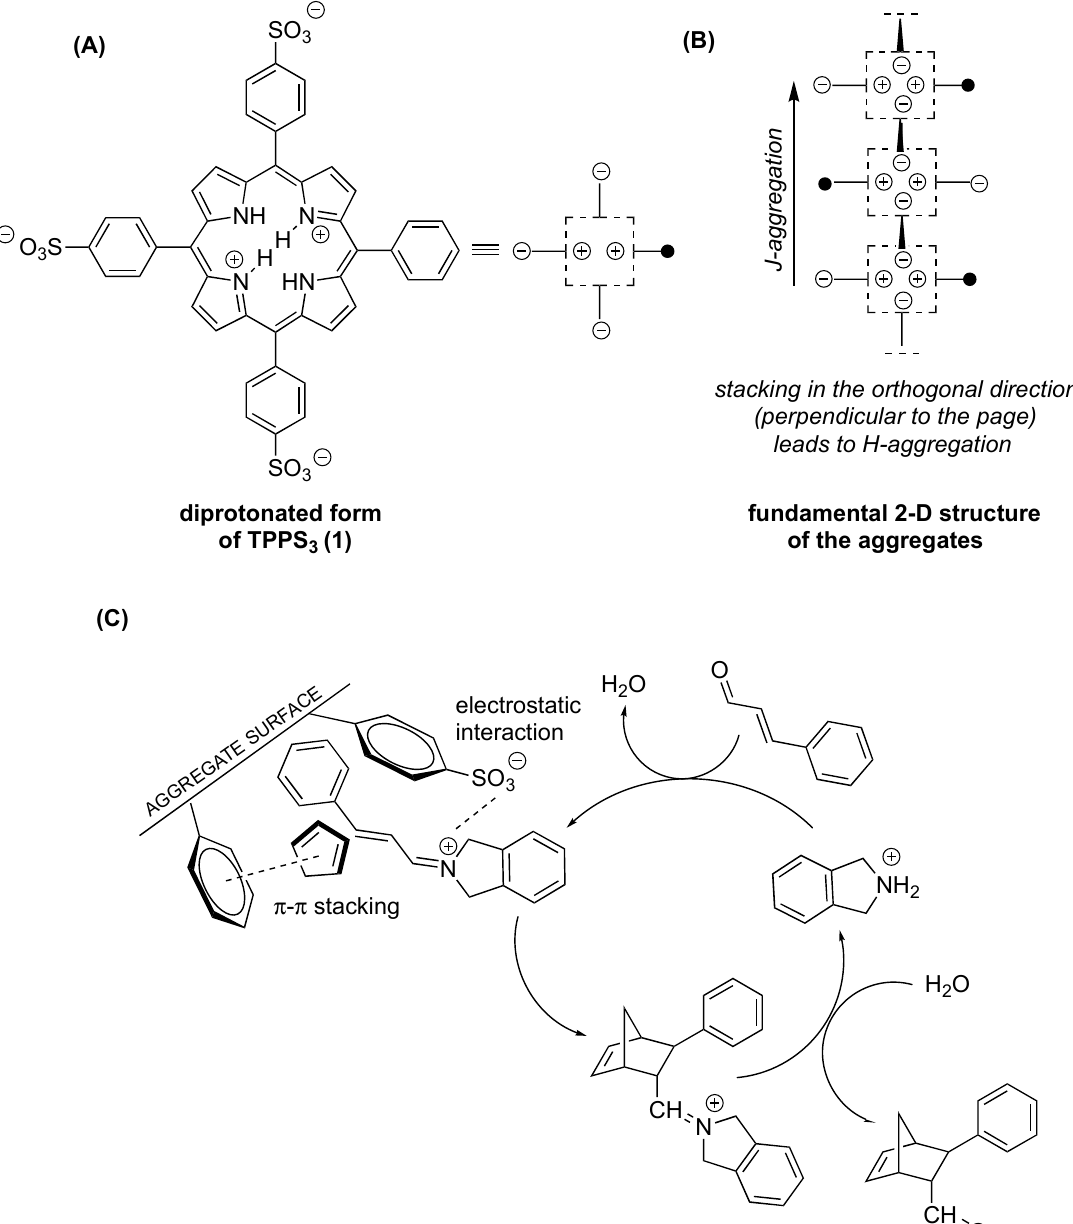
Figure 3. ( A , B ) Fundamental structure of the J -aggregates of diprotonated TPPS 3 ( 1 ); ( C ) Catalysis of the Diels-Alder reaction by the heteroaggregates of general formula ([TPPS 3 − ][R 2 NH 2 + ]) x . We proceeded therefore to test the catalysis of the aqueous Diels-Alder reaction between cinnamaldehyde ( 5 ) and cyclopentadiene ( 6 ) [34] by the zwitterionic heteroaggregates derived from TPPS 3 ( 1 ) and cyclic secondary amines (Scheme 2 and Table 1).